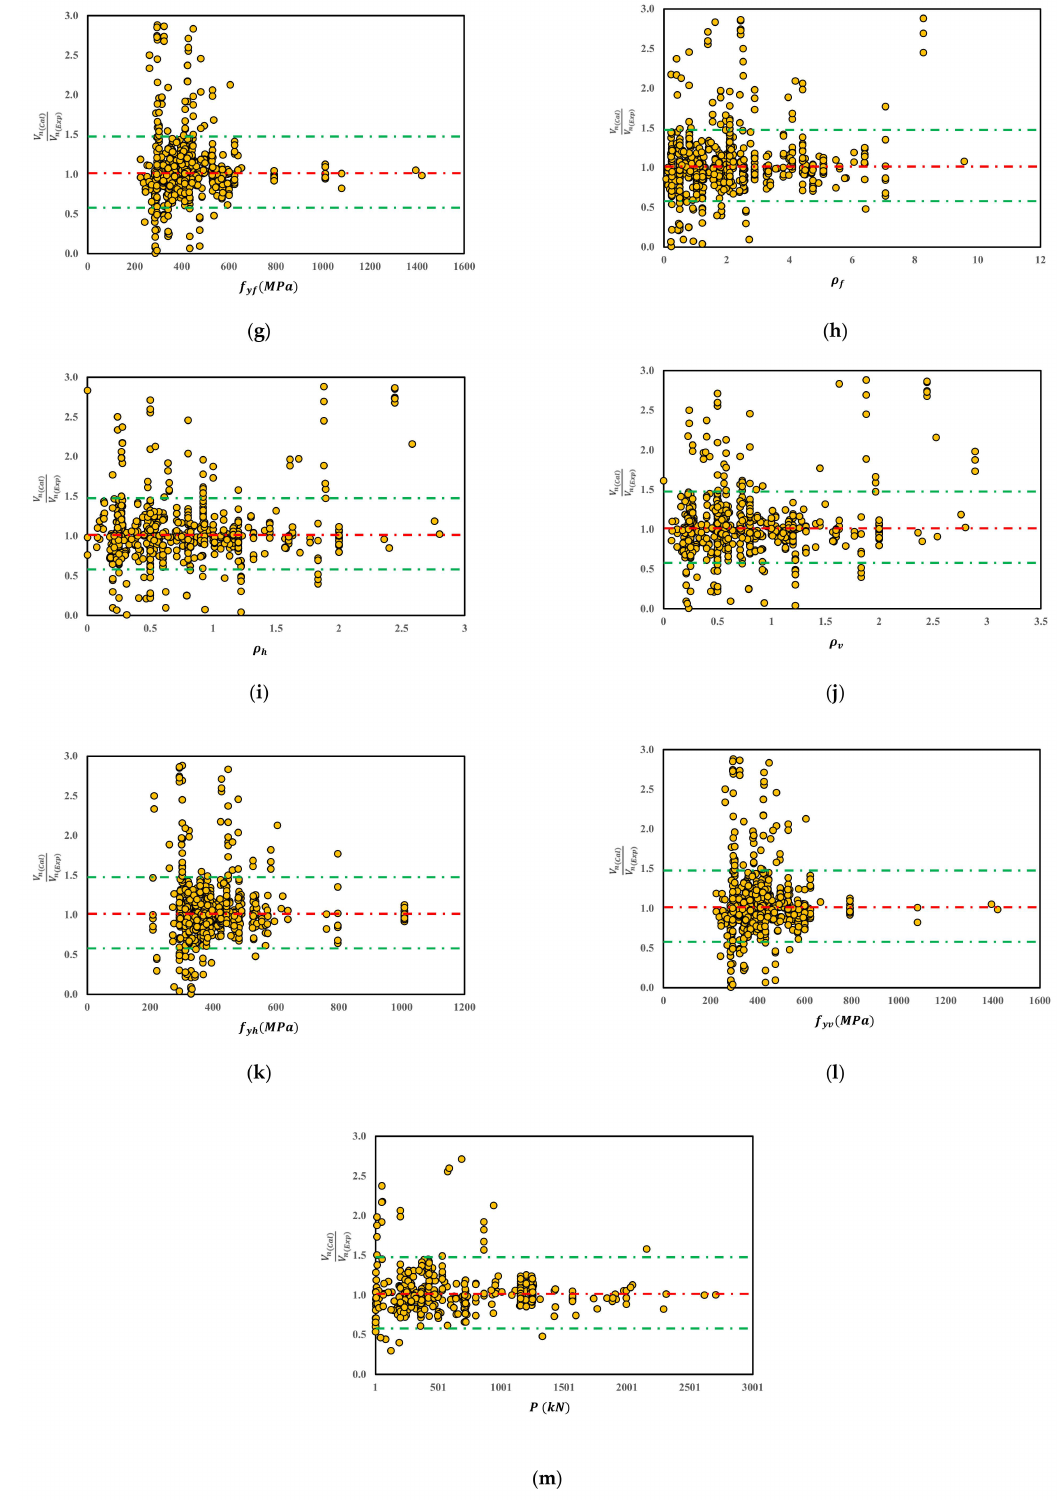
Figure 5. The predictive performance of the proposed shear strength model based on the key parameters. ( a ) Height of wall hw, ( b ) Web length ( l w ), ( c )Web thickness ( t w ), ( d ) Flange thickness ( t f ), ( e ) Flange elements length ( l f ), ( f ) Compressive strength of concrete ( f (cid:48) c ), ( g ) Yield strength of flenged reinforcement ( f yf ), ( h ) Reinforcement ratios of flenge ( ρ f ), ( i ) Reinforcement ratio of wall in the horizontal direction ( ρ h ), ( j ) Reinforcement ratios of wall in vertical direction ( ρ v ), ( k ) Yield strength of the horizontal bars ( f yh ), ( l ) Yield strength of vertical bars ( f yv ), ( m ) Axial load in wall